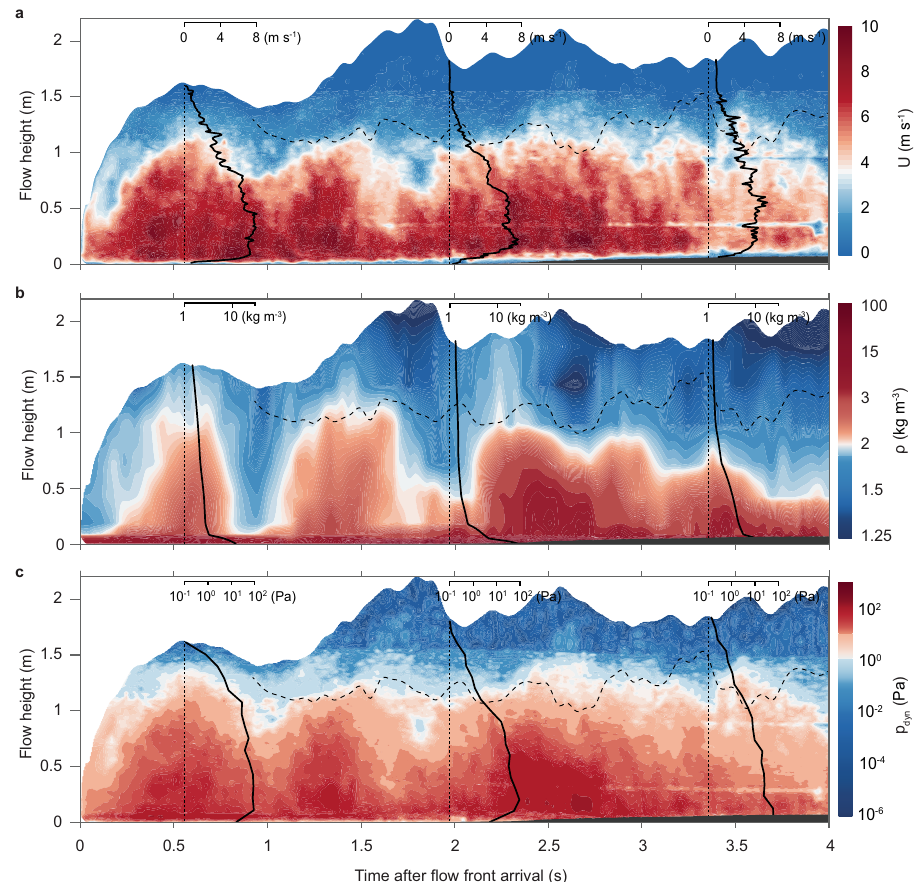
Fig. 3 Low-frequency oscillations of fl ow velocity, density and dynamic pressure and their temporal correlation. Time- and height-variant evolution of the internal fl ow structure at a static observer location at 3.12 m. a contour plot of velocity magnitude U and three instantaneous vertical pro fi les of velocity at 550, 1980 and 3350 ms after fl ow arrival. The data shows regular oscillations of velocity at intervals of c. 800ms. b contour plot of fl ow density fi elds ρ and three instantaneous vertical pro fi les of density at 550, 1980 and 3350 ms after fl ow arrival. The data also shows regular oscillations in fl ow density at intervals of c. 800ms. c , contour plot of dynamic pressure p dyn and three instantaneous vertical pro fi les of dynamic pressure at 550, 1980 and 3350 ms after fl ow arrival. The pressure data also shows the regular oscillations at intervals of c. 800 ms that occur in the velocity and density data. High dynamic pressures of 10s to 100s of Pa persist during the entire fl ow passage. Dashed lines in contour plots mark the boundary between the gravity current body and wake regions. The aggrading deposit at the base of the fl ow is in dark